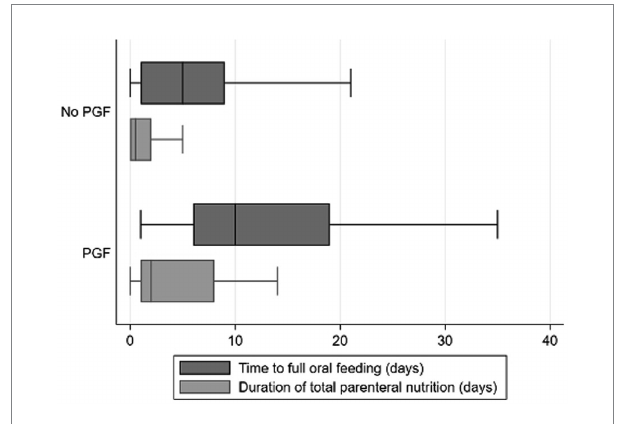
FIGURE 1 Association between decline in a weight-for-age z -score of ≥ 1.2 and time to achieve full oral feeding as well as time spent for total parenteral nutrition. Box and whisker plots were presented for time to full oral feeding (in days; represented by dark gray bars) and time duration of total parenteral nutrition (in days; represented by light gray bars) and as defined by the decline in weight-for-age z -scores of <1.2 (“No PGF”) and ≥ 1.2 (“PGF”). The box contains the 25th to 75th percentile of the dataset, while the central line within the boxes denotes the median value. The whiskers mark the minimum and maximum